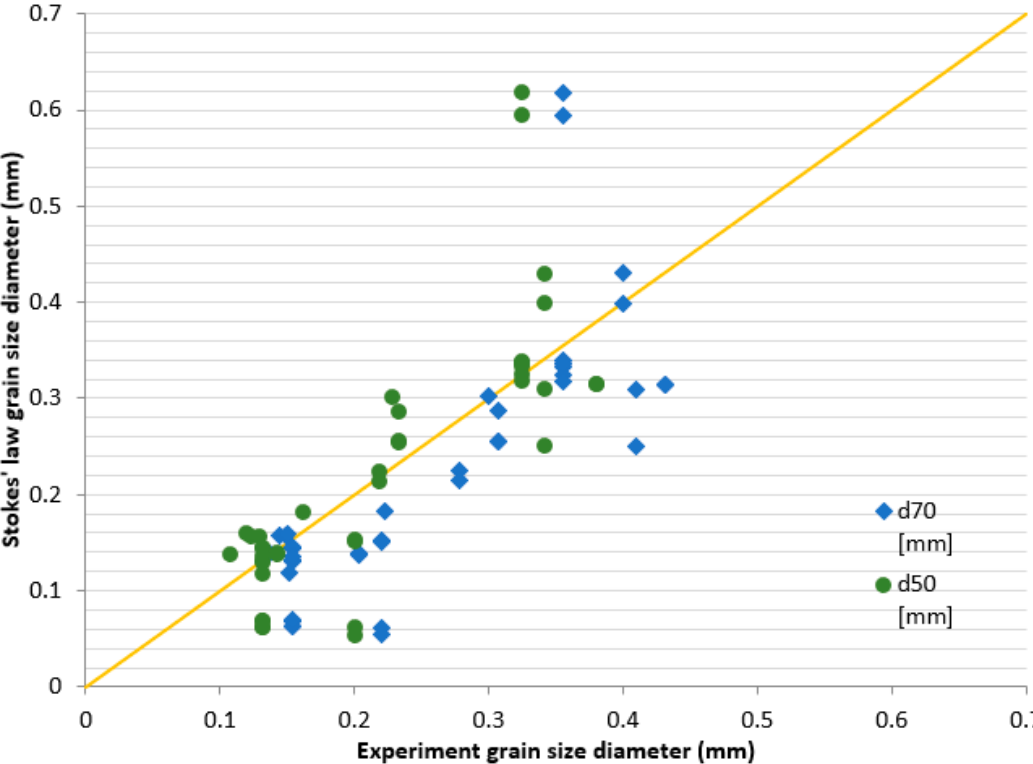
Figure 4. D50 and D70 grain size diameters of the samples from this study and previous studies (Appendix A) versus the median grain size able to be transported by the measured flow in the outflow point during the experiment at the critical gradient. The 1:1 line shows the prediction by Stokes’